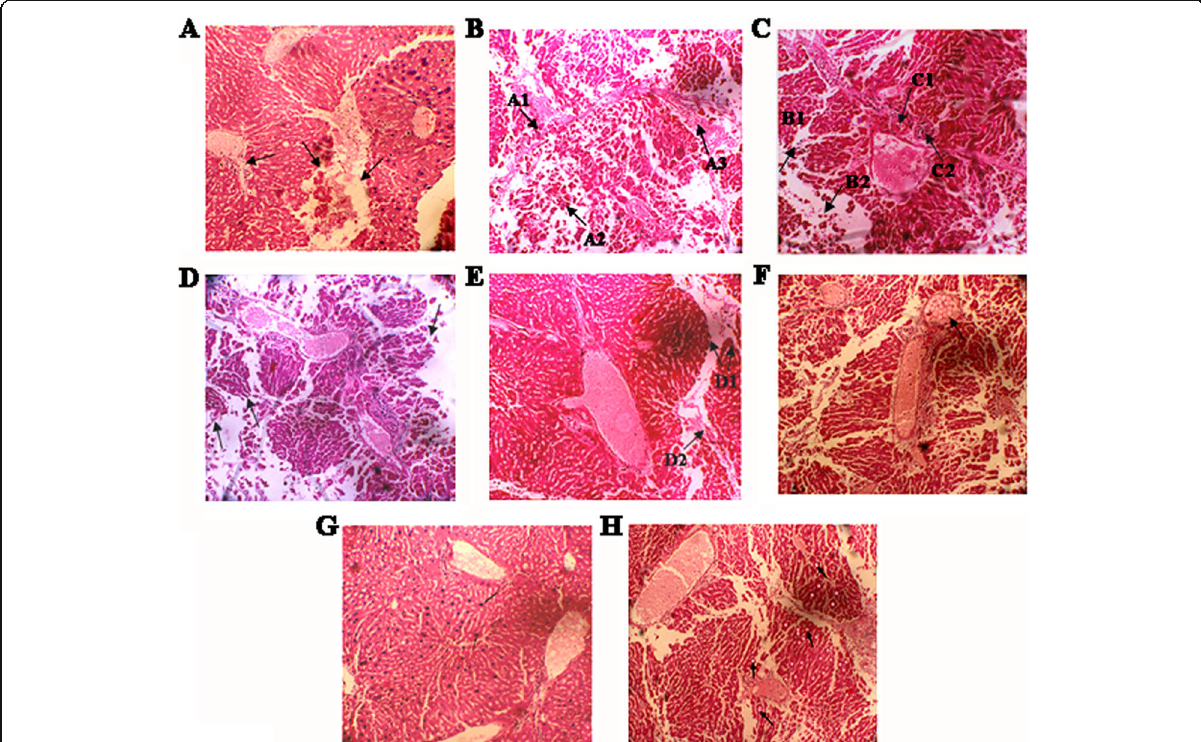
Fig. 6 Hematoxylin and eosin (H&E) stained liver sections of DEN+CCl 4 -induced mice (group V), a Centrilobular necrosis. b Fibrolamellar carcinoma liver where (A1) oncocytes, (A2) cord patterns, and nest formation which were separated by bands of (A3) fibrous stroma. c Peripheral/ periportal necrosis shown by (B1) and (B2), and (C1) and (C2) (pyknotic condition in the nuclei of hepatic cells). d Trabecular or sinusoidal patterns which are made up of 2 – 8-cell-wide layers of tumor cells separated by vascular spaces or sinusoids which are lined by endothelium, e (D1) and (D2) Different changes in liver tissues like nodule formation and fibrosis or cirrhosis, respectively. f Large eosinophilic AHF. g Small basophilic AHF. h Vacuolated cell AHF. H&E stained liver sections are photographed at × 100